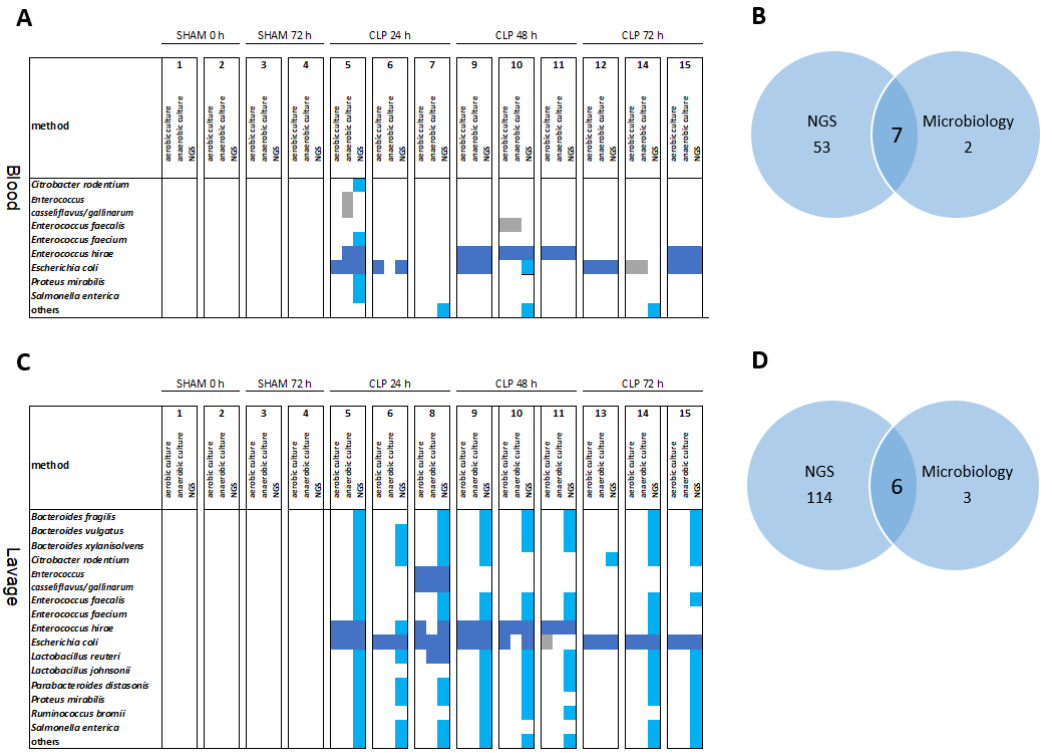
Figure 4. Overlap of microbes in the peritoneum and blood as revealed by NGS and microbiology. The most abundant species are shown for 0–72 h in sham and CLP mice. Heat maps ( A , C ) and Venn diagrams ( B , D ) of the most abundant species in the blood ( A , B ) and abdominal lavage ( C , D ) over 0–72 h in sham and CLP mice. Light blue squares, species detected by NGS (with >10 normalized reads); dark blue squares, species detected by NGS and either aerobic or anaerobic culture; gray squares, species detected by aerobic and/or anaerobic culture only.